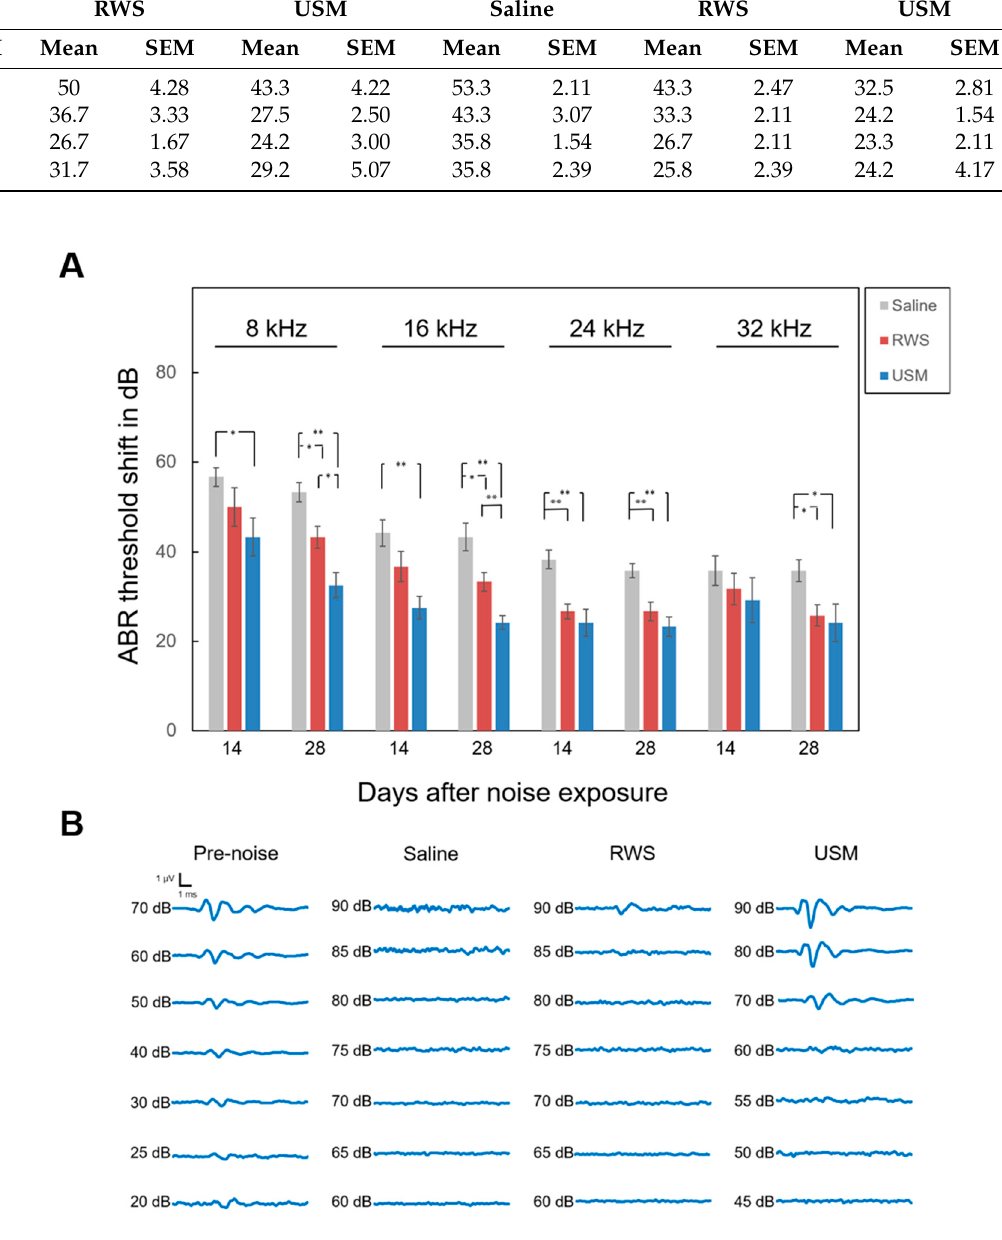
Figure 2. Evaluation of the therapeutic effects of IGF-1 on hearing loss after noise exposure by ABR assessment. ( A ) The ABR threshold shift after noise exposure was compared between the saline-treated, RWS (IGF-1 treatment without USMBs), and USM (IGF-1 treatment with USMBs) groups. The results are expressed as the mean ± SEM; n = 6 for each bar; * p < 0.05, ** p < 0.01. ( B ) Representative ABR response waveforms to 8 kHz stimuli for the three groups before and 28 days after noise exposure. ABR, auditory brainstem response; IGF-1, insulin-like growth factor-1; USM, ultrasound microbubble treatment; RWS, round window soaking.